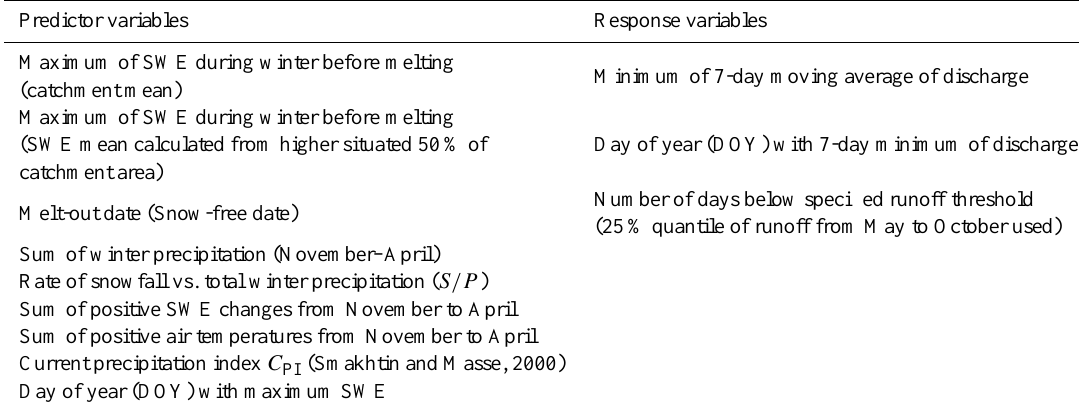
Table 2. Predictor and response variables used in